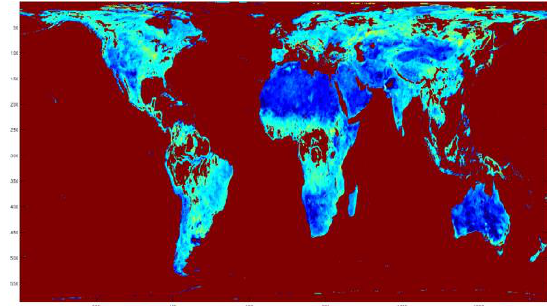
Figure 5. The soil moisture ground truth from